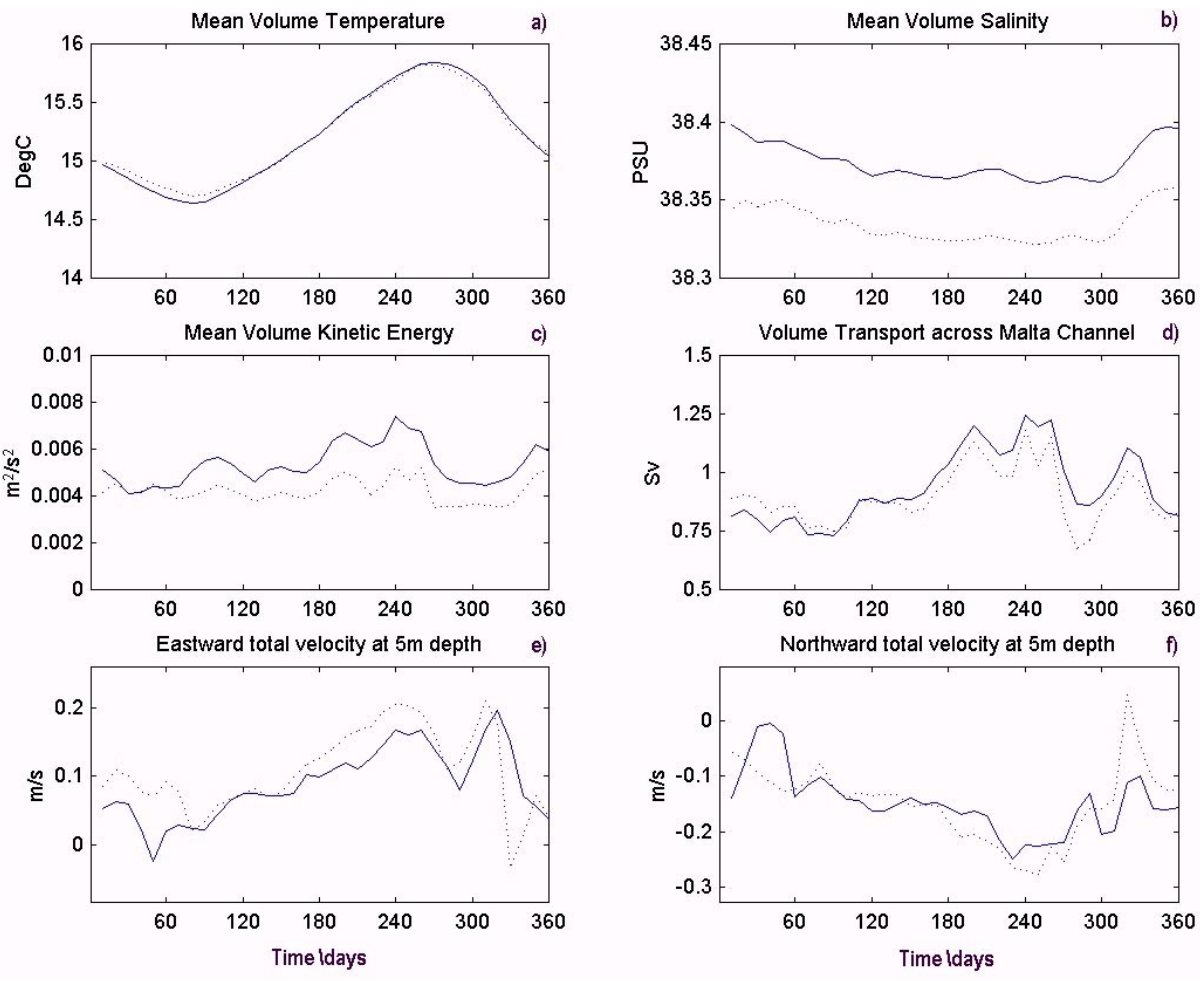
Fig. 8. Comparison between the inner shelf scale (solid line) and outer coarse scale (dotted line) models by 10-day averaged time series of mean volume (a) temperature, (b) salinity and (c) kinetic energy calculated over the inner model domain; (d) volume transport across the vertical section running along 14.4 ◦ E; (e) E-W and (f) N-S total velocity components at 5m depth taken from the model output at a common point in the middle of the Malta Channel (36.4 ◦ N , 14.4 ◦